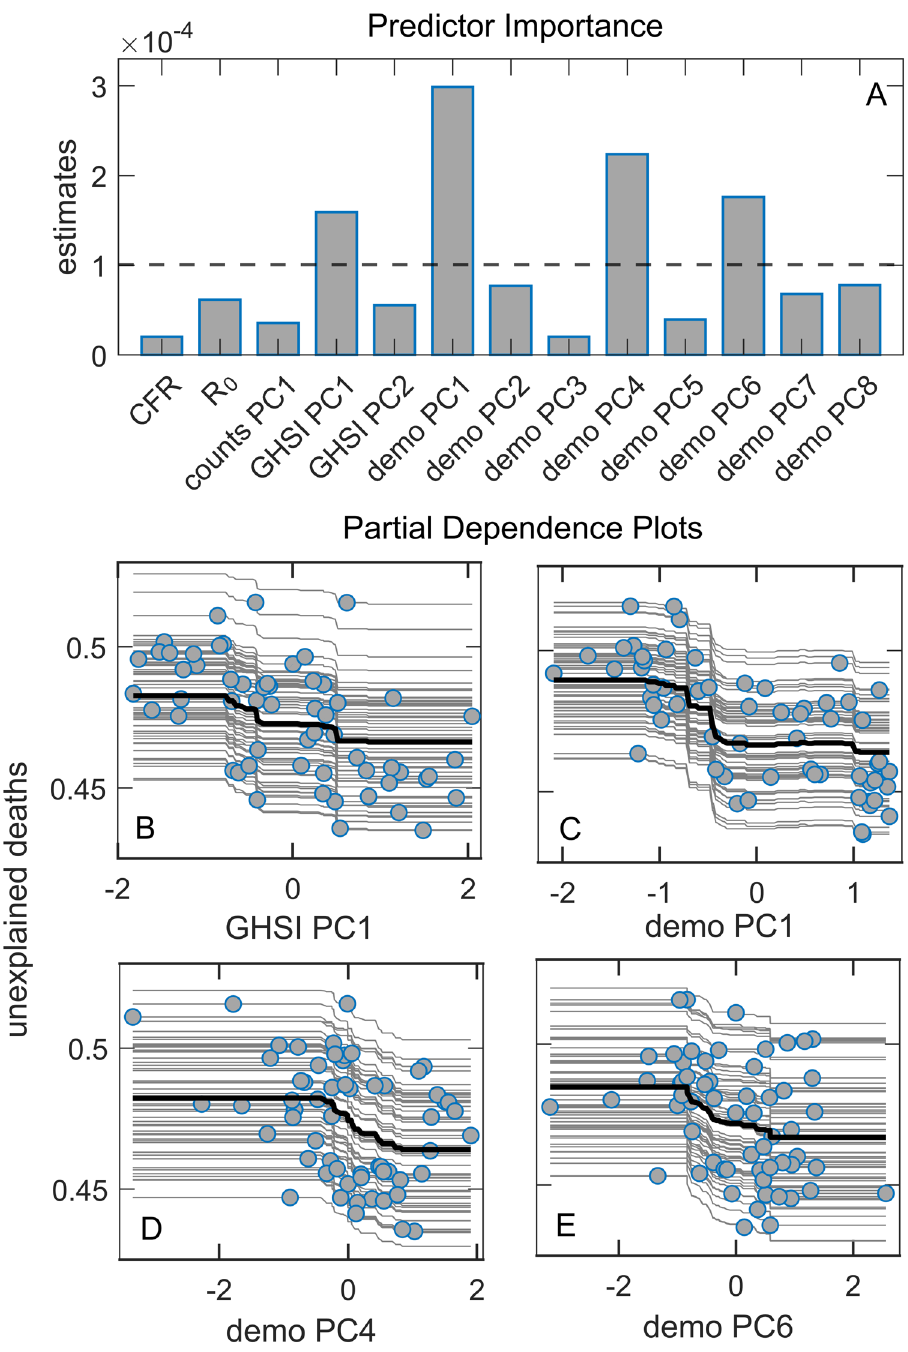
Figure 6. Random Forest regression with unexplained deaths as the response. ( A ) Predictor importance estimates from Random Forest regression, where dashed line represents the importance threshold (the mean value of the variables), ( B – E ) Partial dependence plots od predictor with the highest importance estimates from Random Forest regression model, CFR – case fatality rate, R 0 – basic reproductive number of the